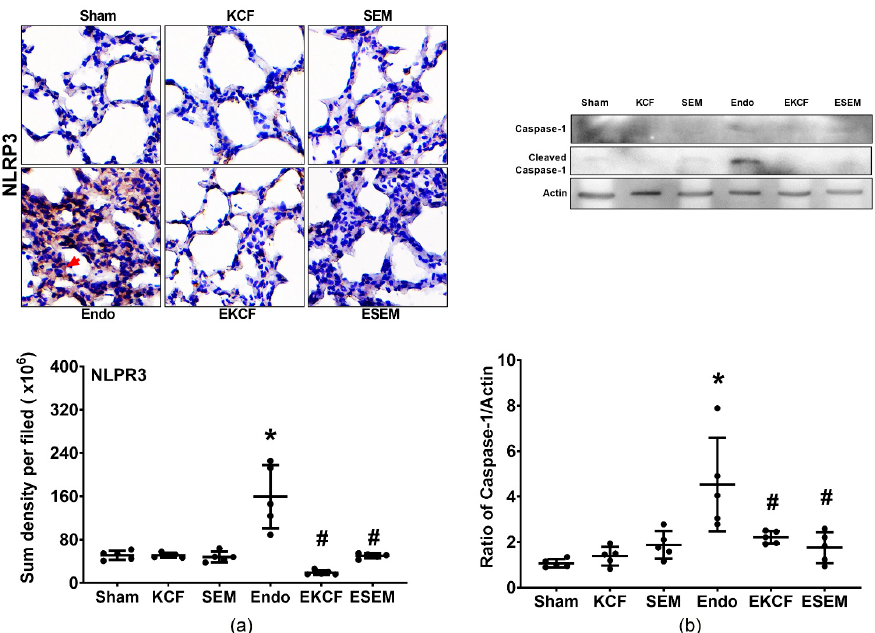
Figure 7. Lung pyroptosis status. ( a ) Representative microscopic images of nucleotide-binding oligomerization domain-like receptor protein 3 (NLRP3, the indicator of pyroptosis, marked by the red arrow, 200 × ) in lung tissues assayed using immunohistochemistry analysis and the sum of the NLRP3 signal intensity. ( b ) Representative gel images of cleaved caspase-1 and actin (the internal standard) in lung tissues assayed using immunoblotting assay and the relative band density of cleaved caspase-1/actin in lung tissues. All assays were measured at 24 h after endotoxin or normal saline administration. Sham: the normal saline group. KCF: the normal saline plus the KCF18 peptide group. SEM: the normal saline plus the SEM18 peptide group. Endo: the endotoxin group. EKCF: the endotoxin plus the KCF18 peptide group. ESEM: the endotoxin plus the SEM18 peptide group. Data were obtained from 5 mice in each group and presented as the mean ± standard deviation. * p < 0.05, versus the Sham group. # p < 0.05, versus the Endo group.